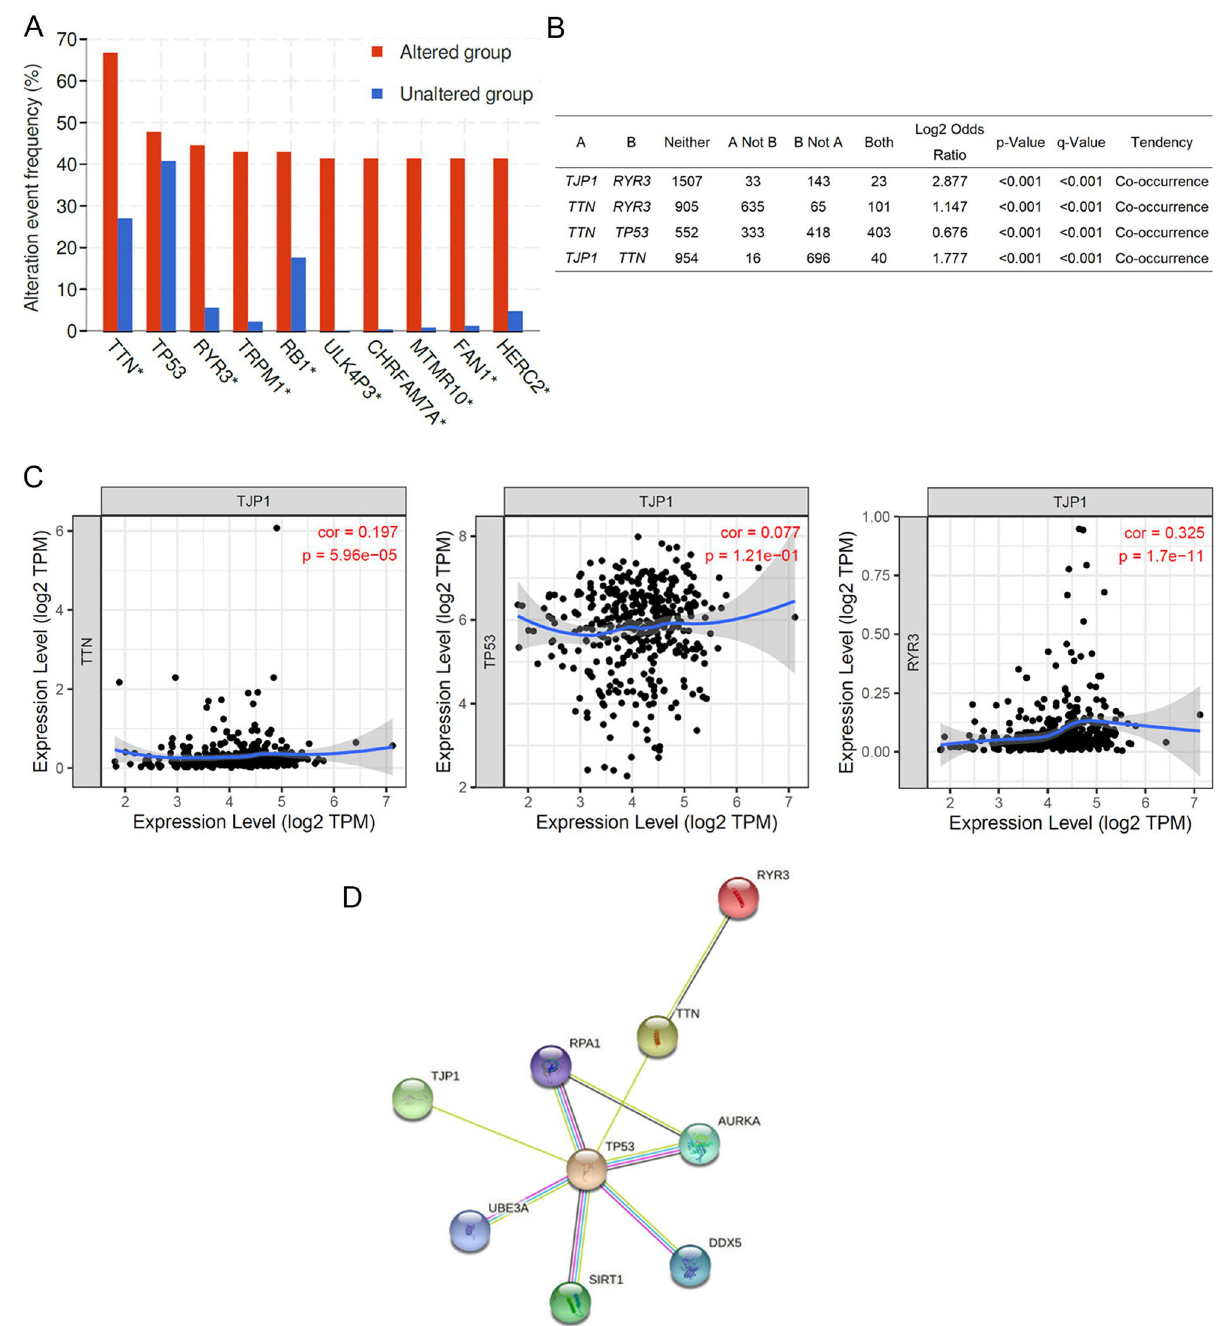
Figure 5. Correlation analysis of TJP1 and oncogenes in bladder cancer patients. ( A ) Frequency of genomic alteration in tumors from bladder cancer patients. * p < 0.05. ( B ) Major co-occurrences of genomic alterations of TJP1 and TTN, TP53 and RYR3 in bladder cancer patients. ( C ) Analysis of the correlation between TJP1 and TTN / TP53 / RYR3 mRNA expression using TIMER. ( D ) STRING protein–protein interaction networks for TJP1, TP53, TTN and